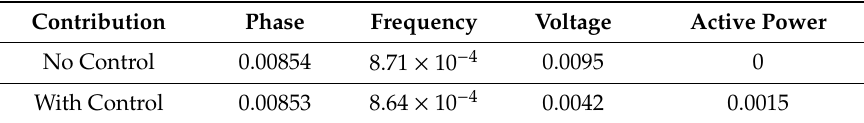
Table 3. Objective function values and contributions.